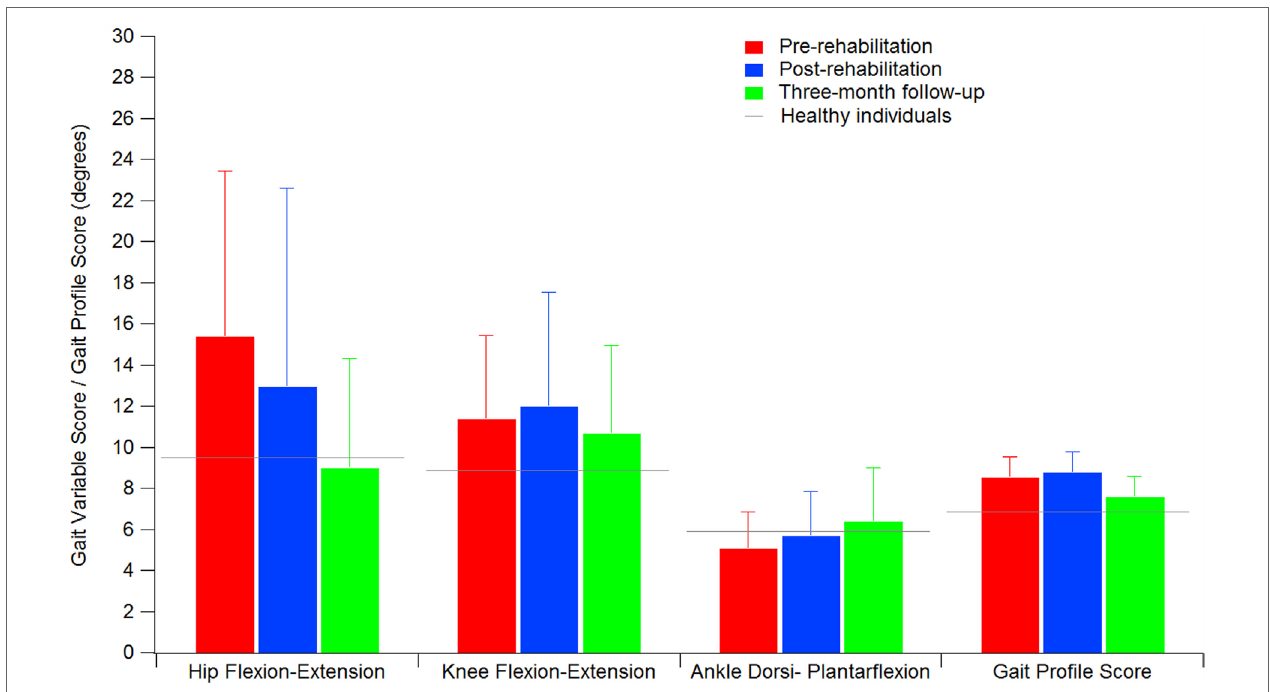
FigUre 2 | gPs and gVs of hip, knee, and ankle in the sagittal plane of the participants with PD . Gray lines indicate the reference values calculated for a sample of healthy individuals. Error bars indicate SD.